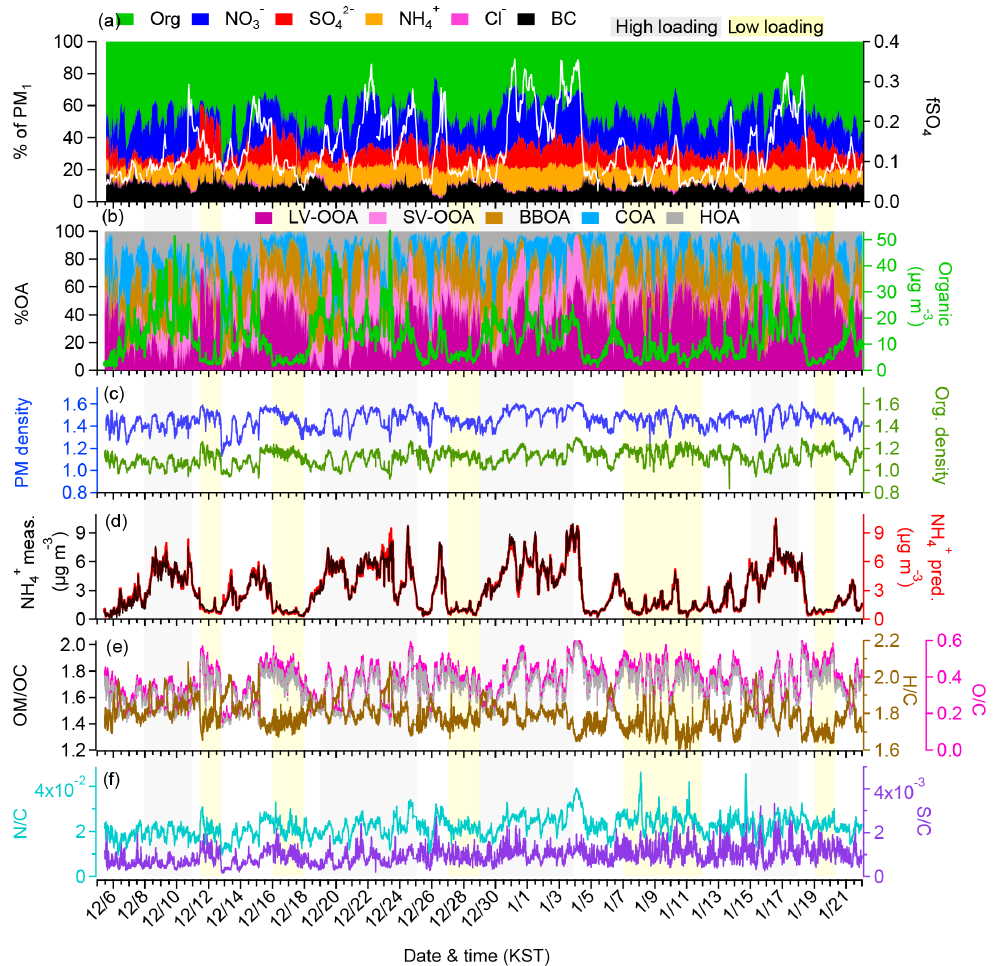
Figure 3. Overview of the chemical composition of submicron aerosols at the KIST in Seoul from 5 December 2015 to 21 January 2016. (a) Time series of the mass fractional contribution of organic aerosols (Org.), nitrate (NO − (Cl − ), and BC to total PM 1 . Also shown is the time series of f SO 4 (ratio of SO 2 − contribution to total organic aerosol (OA) of the five factors derived from the positive matrix factorization (PMF) analysis (see Sect. 3.3), and the time series of the organic aerosols; (c) time series of the organic density estimate using the method reported in Kuwata et al. (2012), with bulk aerosol density using the organic density estimated in this figure; (d) time series of the measured and predicted NH + (e,f) organic matter-to-organic carbon (OM / OC), oxygen-to-carbon (O / C), hydrogen-to-carbon (H / C), nitrogen-to-carbon (N / C), and sulfur-to-carbon (S / C) ratios of OA, where the O / C, H / C, and OM / OC elemental ratios were determined using the updated method (Canagaratna et al.,